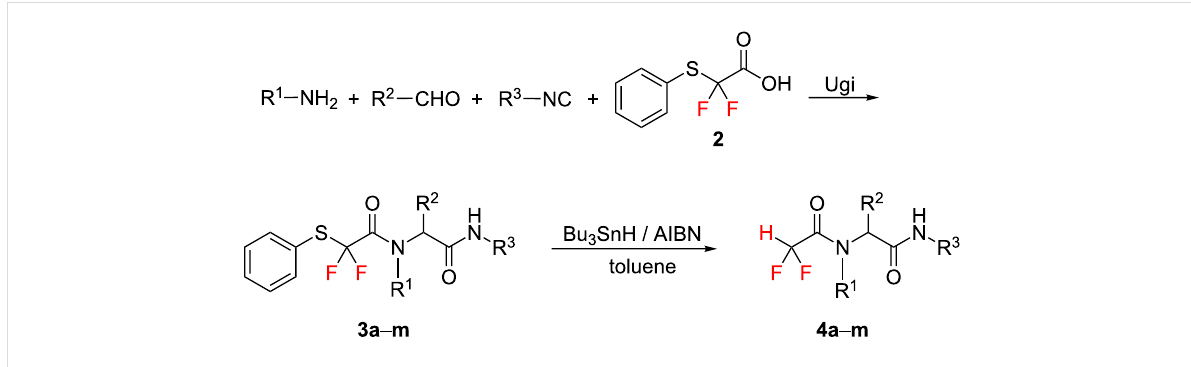
Scheme 1: Synthesis of difluoromethyl-containing pseudopeptides ( 4a – m) by Ugi reaction and